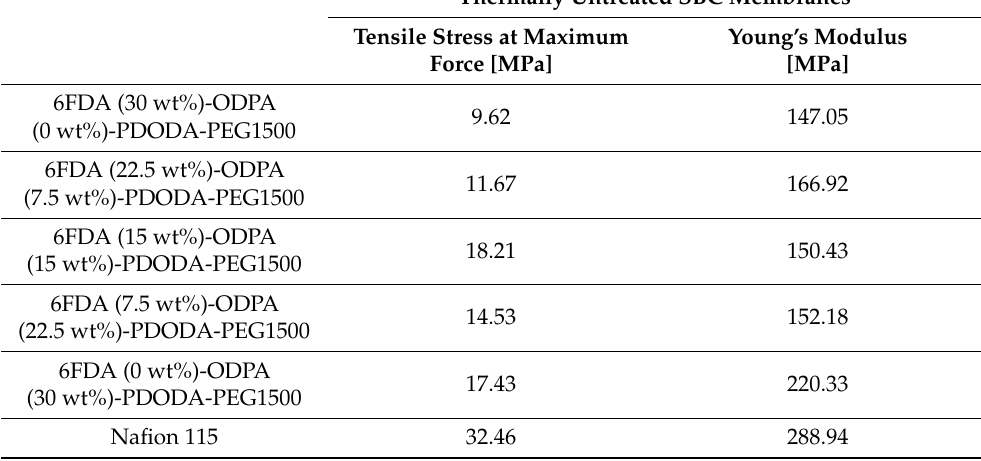
Table 8. Tensile stress at maximum force and the Young’s modulus of the SBC membranes with changing dianhydride composition and constant PEG content of 42.1 wt% (dianhydride entities are written in bold